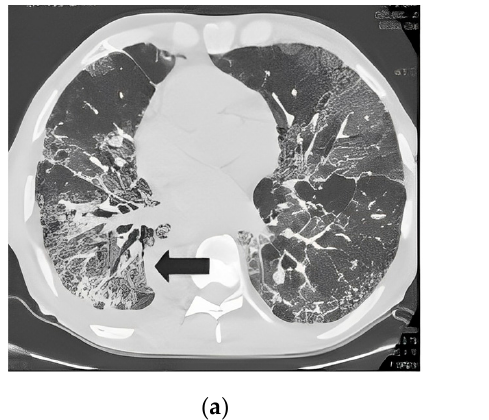
Figure 1. An example of applying an augmentation method. ( a ) The original image; ( b ) After apply- ing an augmentation method.